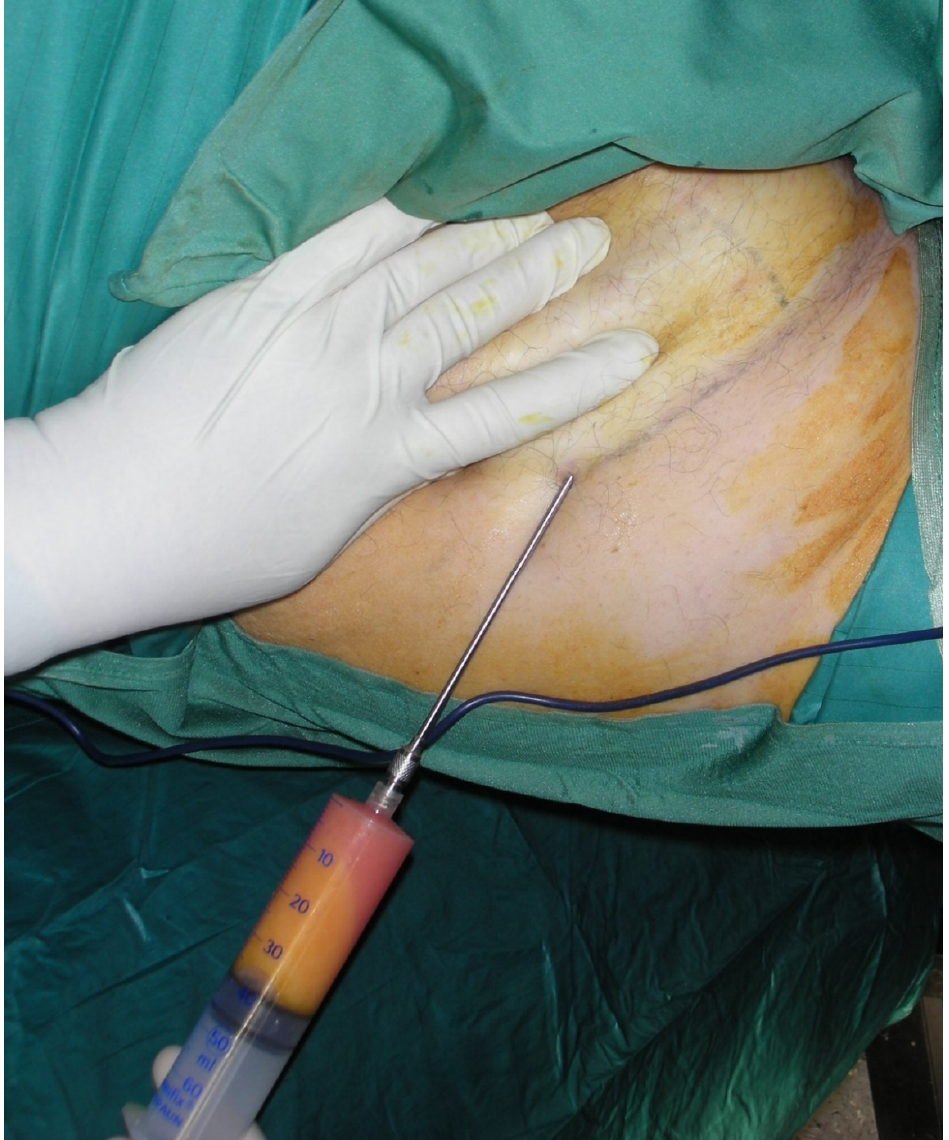
Figure 1. Fat harvesting technique. The adipose tissue is aspirated under moderate manual negative pressure, using a 60 mL syringe connected to a 3 mm cannula.